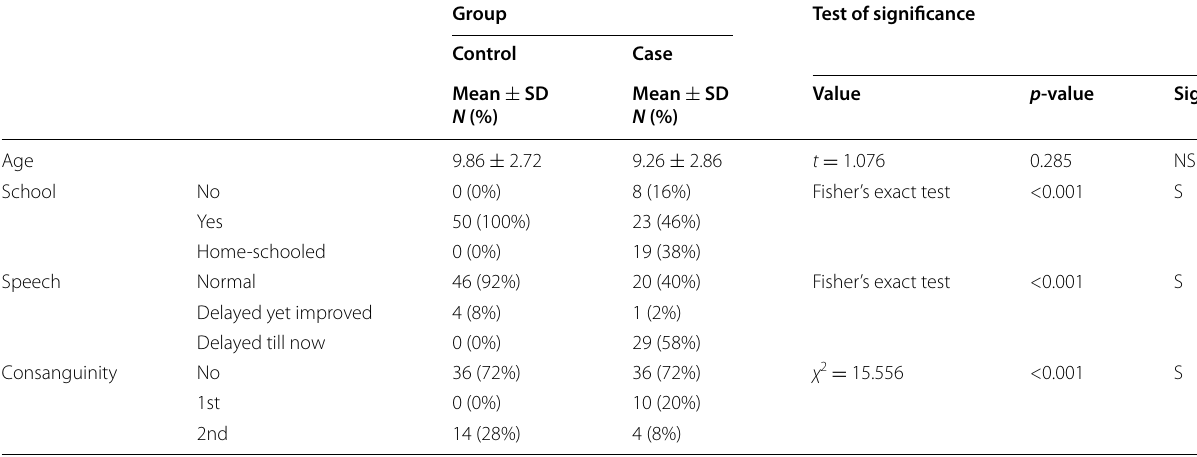
Student t test of significance ( t ). Chi-square test of significance ( χ 2 ) Table 2 Comparison between cases and control regarding Full Scale IQ (FSIQ)